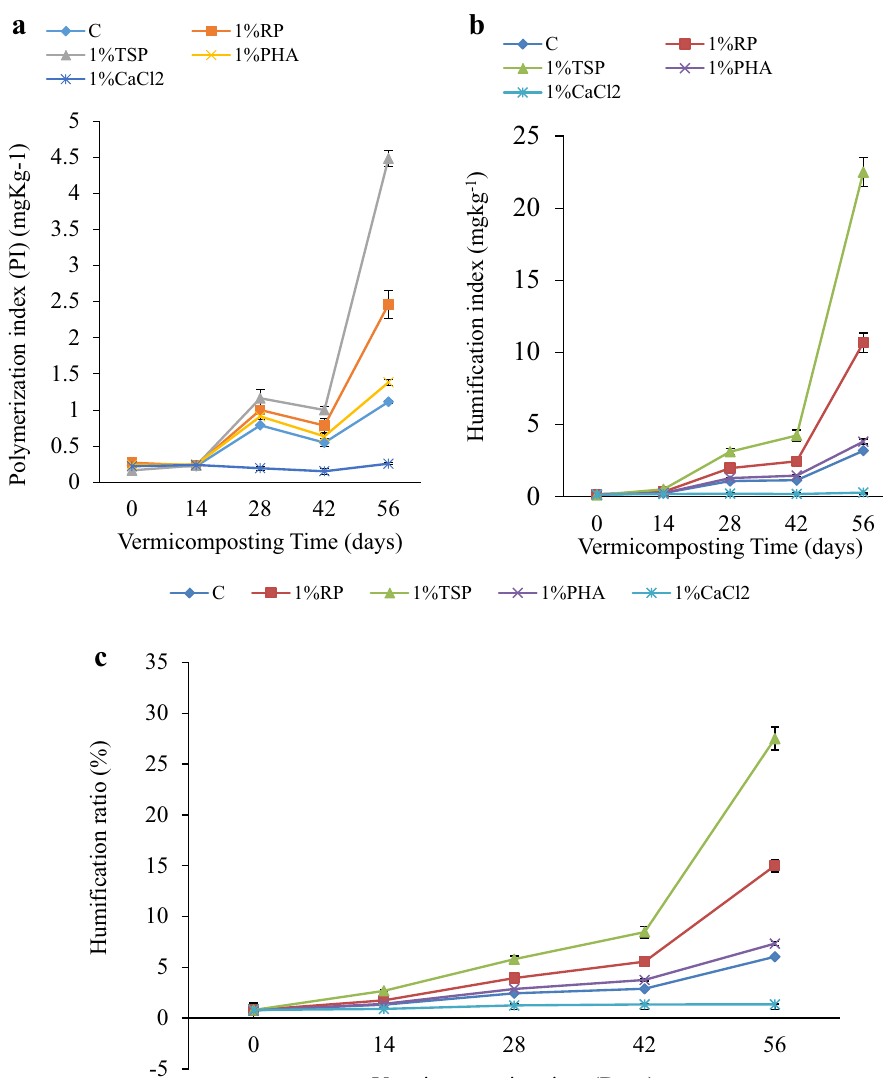
Fig. 5 Effect of P and Ca source on the humification